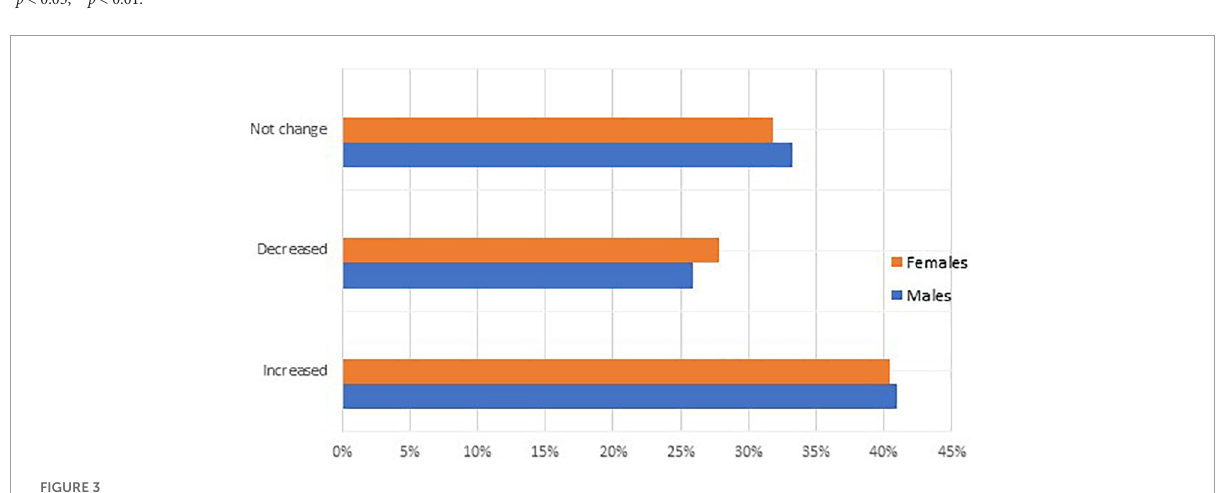
FIGURE3 BMI during the confinement